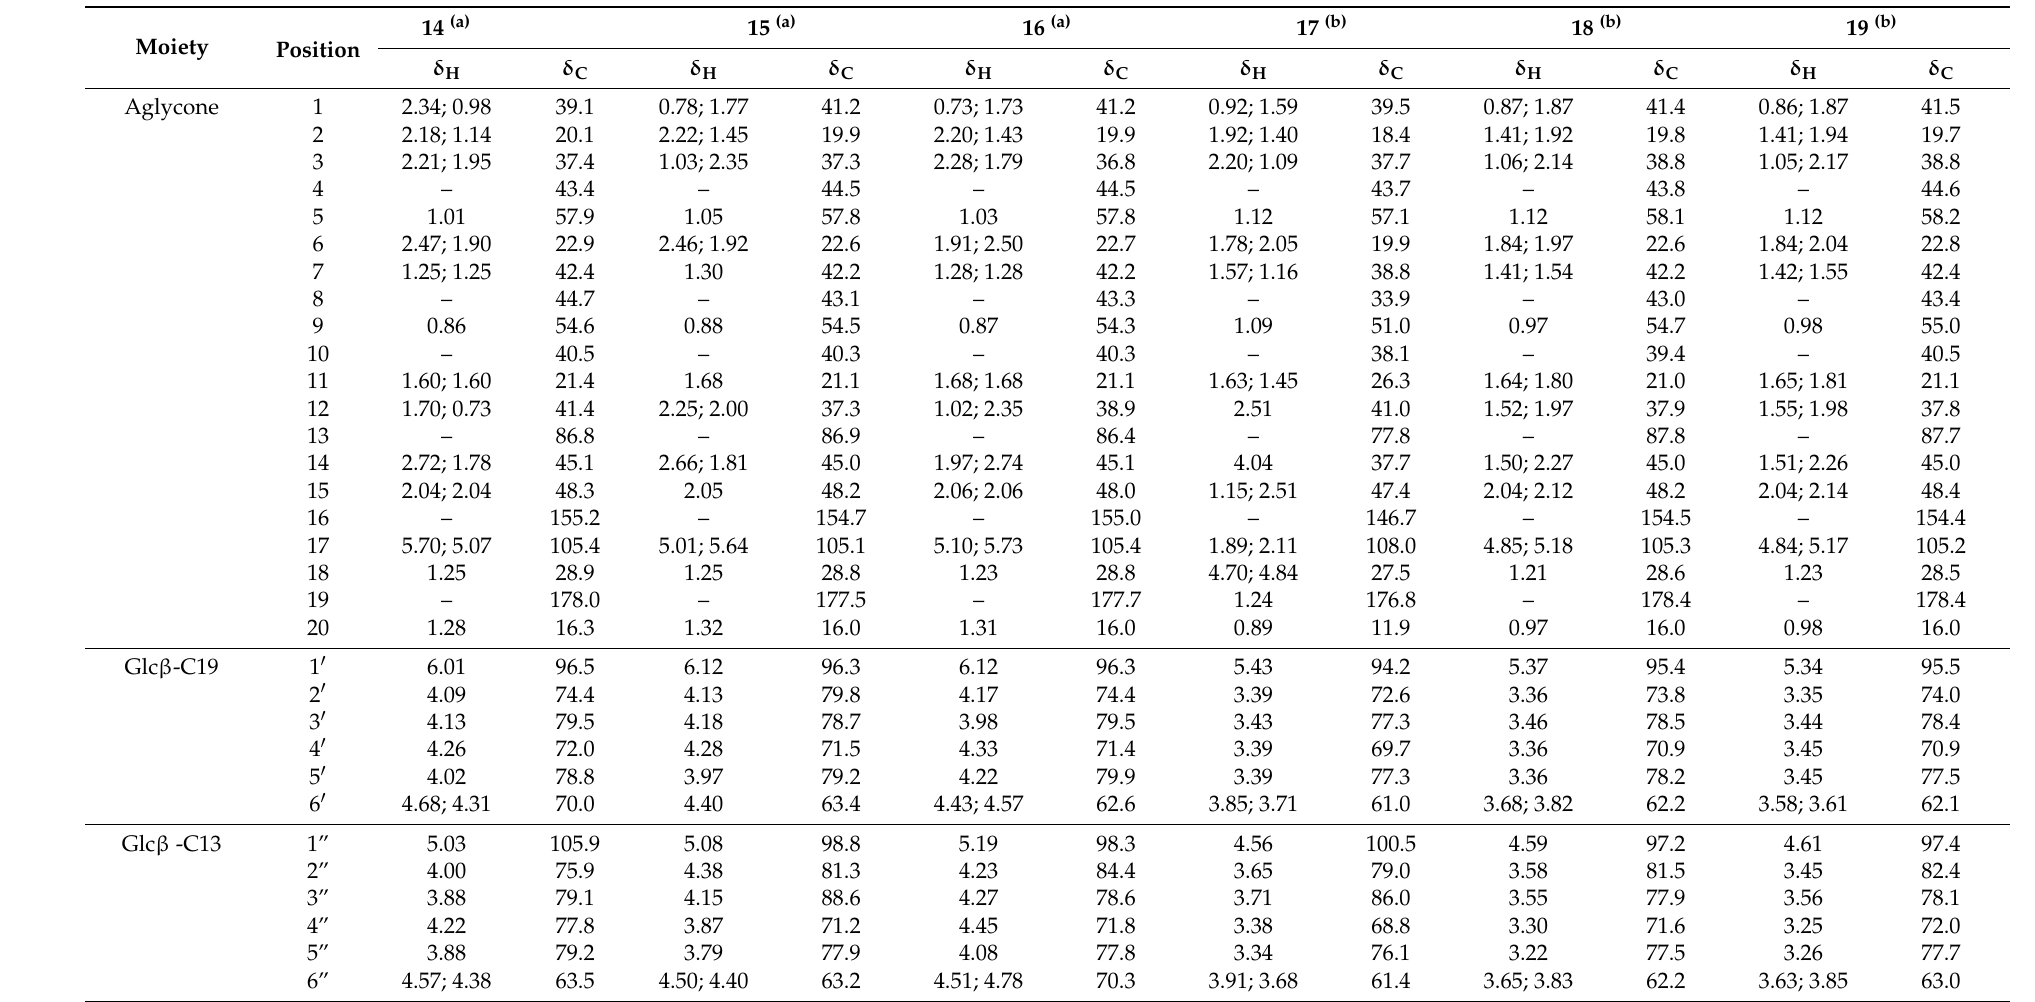
Table 6. 1 H and 13 C chemical shifts of the compounds 14 – 19